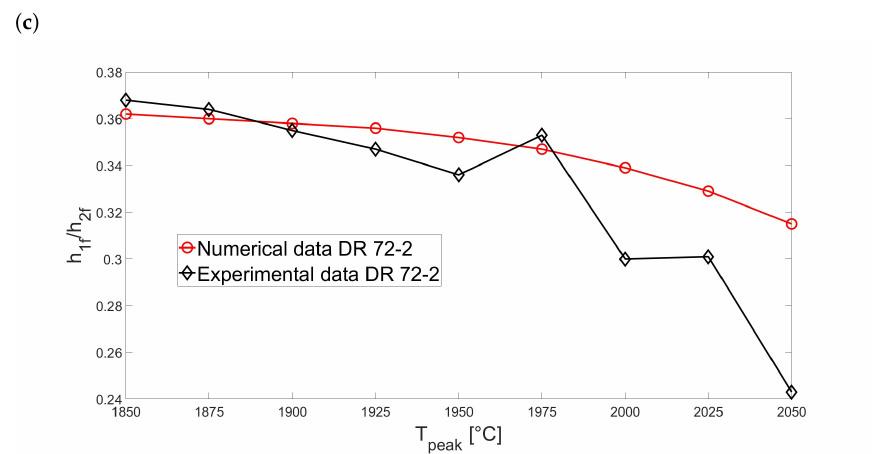
Figure 6. Comparison between the final air-filling fraction of the capillary obtained numerically and experimentally by Luzi et al. [20] for the three different drawing ratios ( a ) DR36-1, ( b ) 54-15, and ( c ) 72-2 at different furnace peak temperatures.